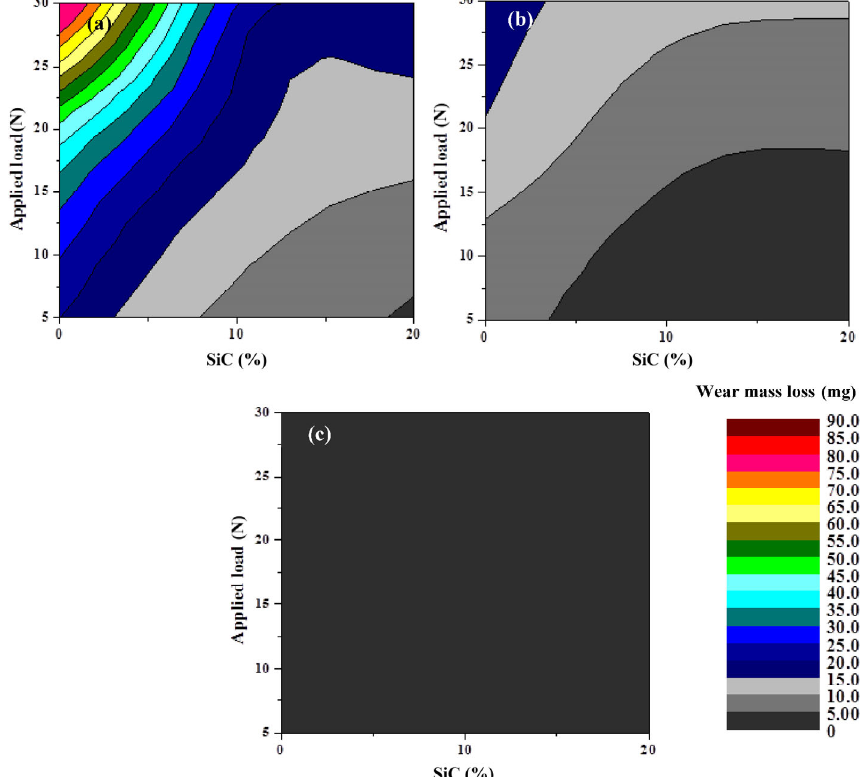
Fig. 3 Wear mass loss map of (a) cold compacted, (b) sintered, and (c) HPTed Cu and Cu-SiC composites samples under different applied load and sliding distances of 2,500